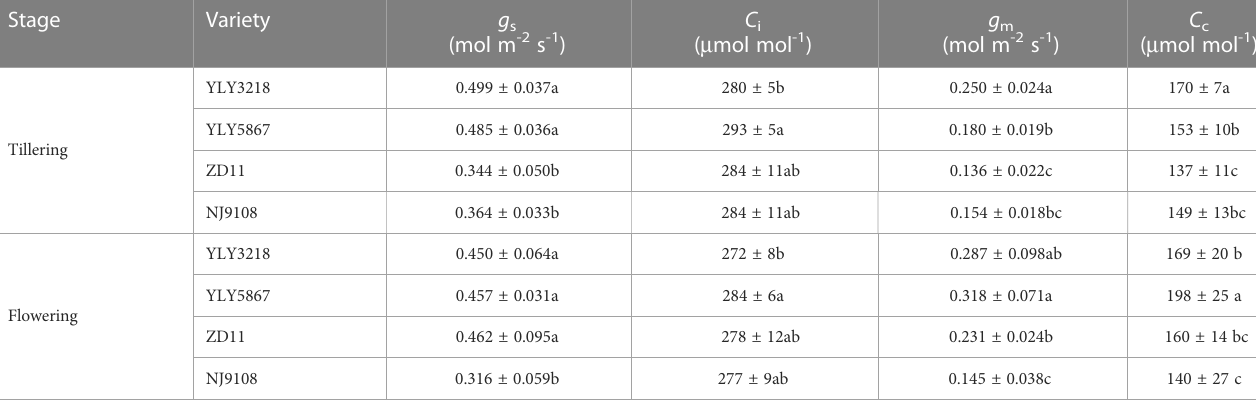
TABLE 1 CO 2 diffusion parameters pf the latest fully expanded leaves for different rice cultivars during tillering stage and fl owering stage. Stage